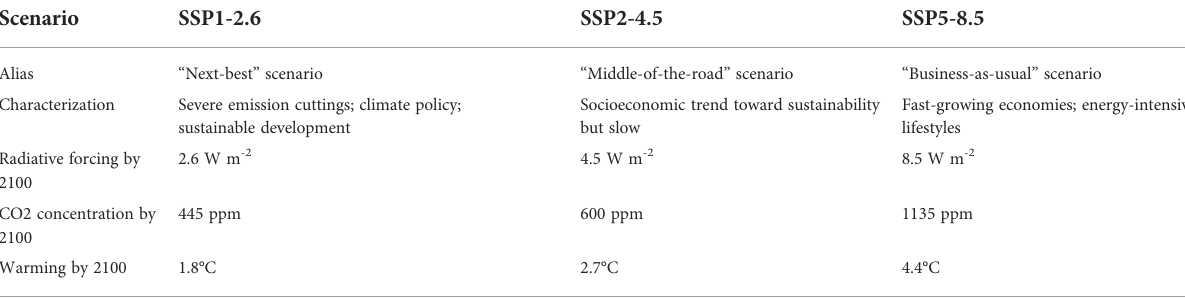
TABLE 3 Overview of the climate change scenarios used in this analysis.